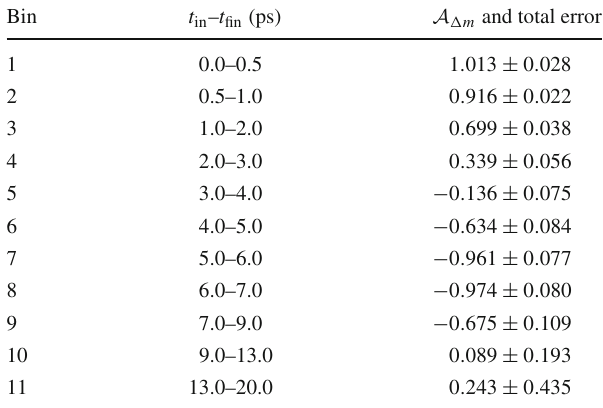
Table 1 Time-binned data set for the asymmetry A (cid:2) m as given in [25] Bin t in – t fin